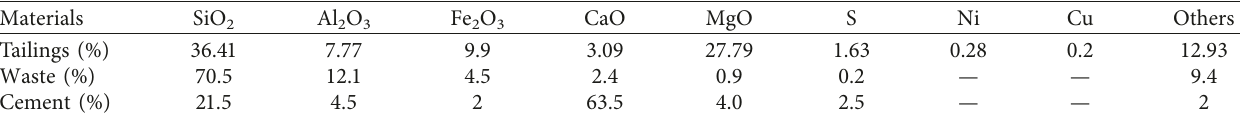
Table 2: Chemical compositions and some physical properties of the materials.